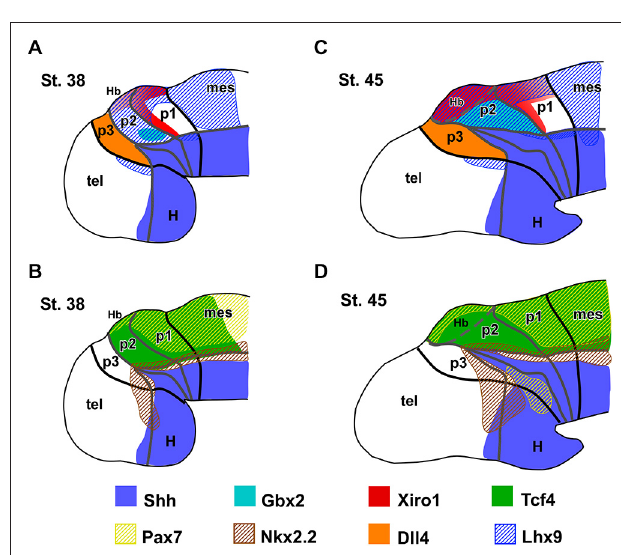
FIGURE 7 | Expression patterns of the main thalamic markers. Summary diagrams representing in lateral view of the forebrain the extent of the expressions of the main markers analyzed in Xenopus with respect to the thalamus and neighboring regions at early (A,B) and late (C,D) embryonic